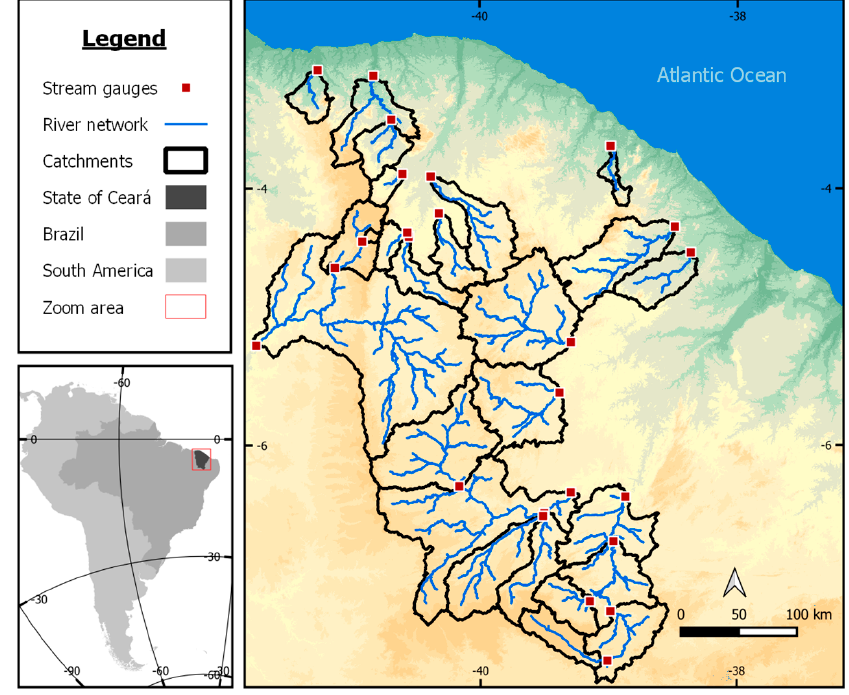
Figure 1. Studied catchments.